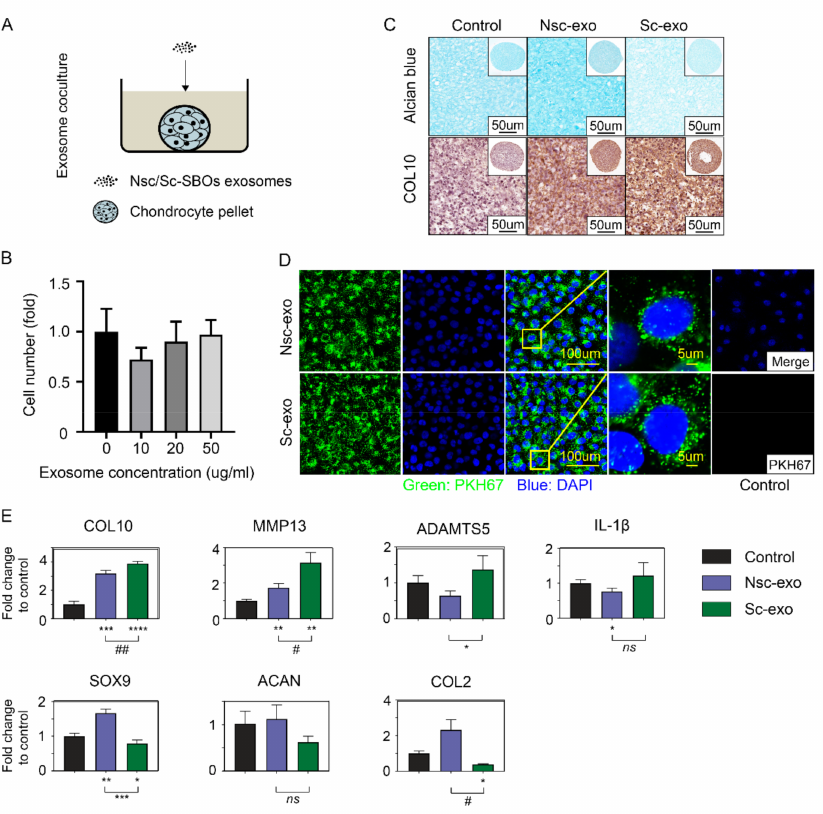
Figure 2. Sc-SBOs secreted exosomes contribute to cartilage degeneration. ( A ) Coculturing model of ACCs pellets and Nsc/Sc-SBOs exosomes. ( B ) Proliferation assay of ACCs cocultured with SBOs exosomes in 0/10/20/50 µ g/mL (n = 3). ( C ) Alcian blue staining (top) and immunostaining (bottom) analysis of ACCs pellets cocultured with Nsc/Sc-SBOs exosomes (n = 3 patients). ( D ) PKH67-marked exosomes staining with ACCs (images are representative of n = 3 patients) and negative control. ( E ) Real-time PCR analysis of ACCs pellets cocultured with Nsc/Sc-SBO derived exosomes (n = 3), represented as the mean ± SD; *, p < 0.05, **, p < 0.01, ***, p < 0.001, ****, p < 0.0001; ##: Very significant, #: Significant; ns: Not